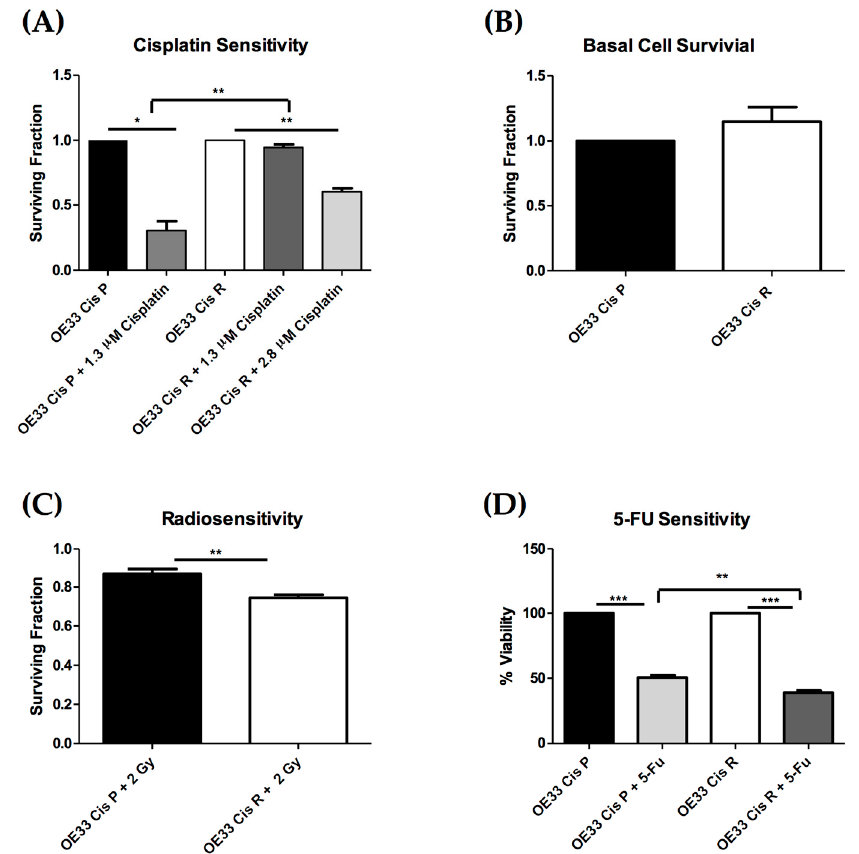
Figure 2. Cisplatin-resistant (OE33 Cis R) oesophageal adenocarcinoma cells are more radiosensitive than cisplatin-sensitive (OE33 Cis P) oesophageal adenocarcinoma (OAC) cells. ( A ) The sensitivity of cisplatin-sensitive (OE33 Cis P) and cisplatin-resistant (OE33 Cis R) OAC cells to cisplatin was assessed by clonogenic assay (n = 3). ( B ) There is no difference in the basal cell surviving fraction of cisplatin-sensitive and cisplatin-resistant OAC cells cultured in RPMI media, (n = 3). ( C ) Surviving fraction of Cis P and Cis R OAC cells following treatment of one 2 Gy fraction of irradiation, (n = 3). ( D ) The viability of the OE33 Cis R cells was significantly decreased compared to the OE33 Cis P when treated with 12 µ M of 5-fluorouracil (5-FU) (n = 4). An unpaired t -test was used to compare between different cell lines, and a paired t -test was used to compare between the same cell line. Data presented as ± SEM * p < 0.05, ** p < 0.01, *** p < 0.0001.